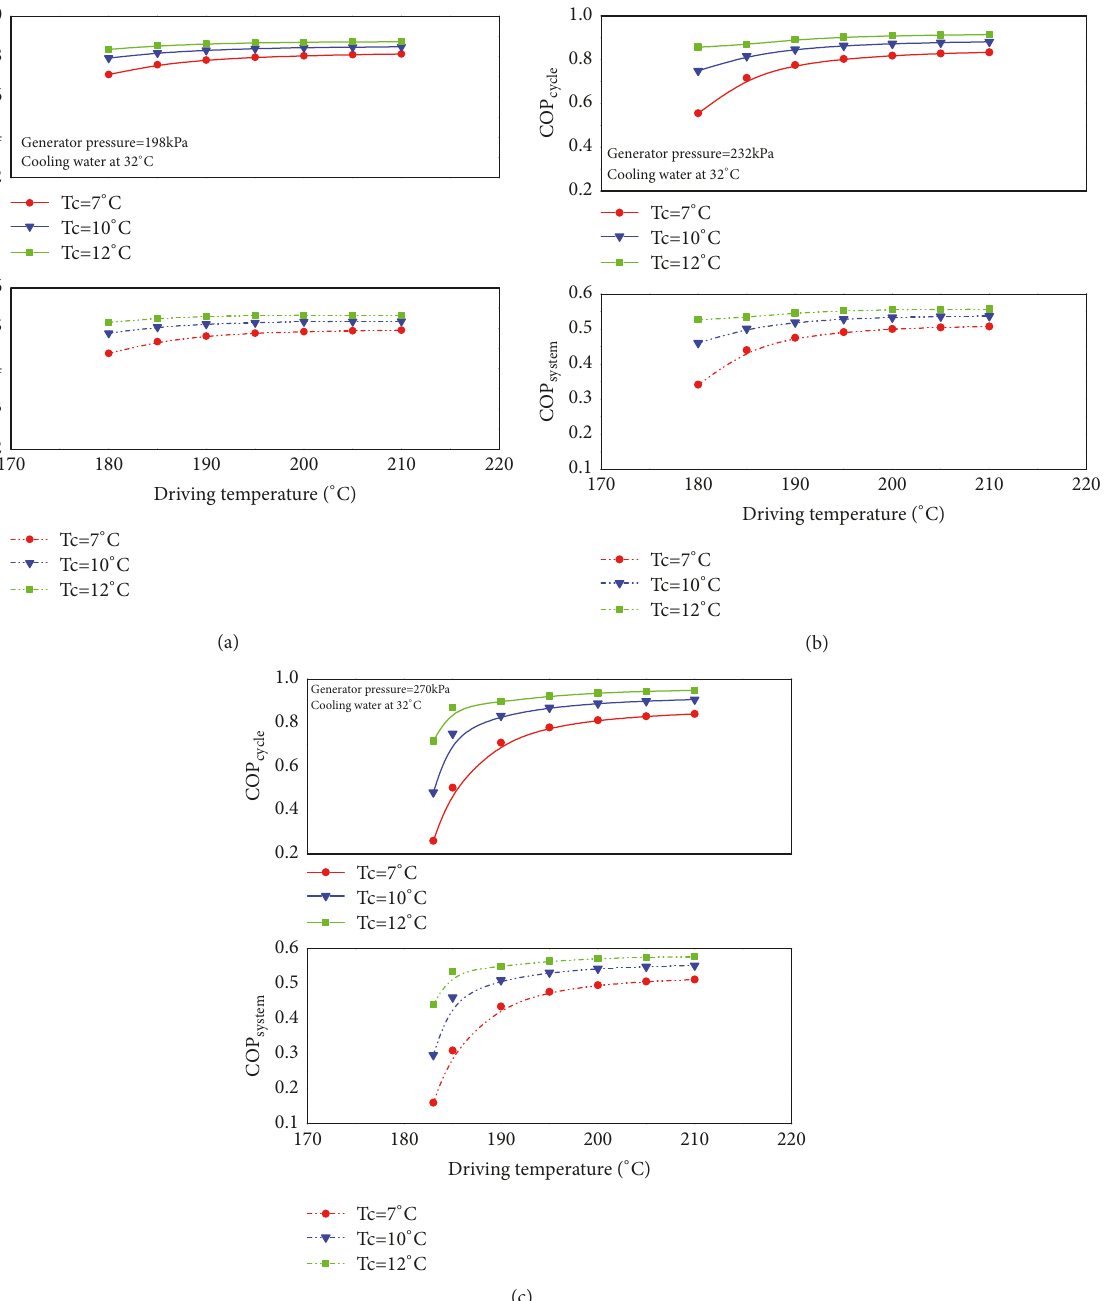
Figure 6: Effect of generator temperature on system performance for different generator pressures and chilled water temperatures.